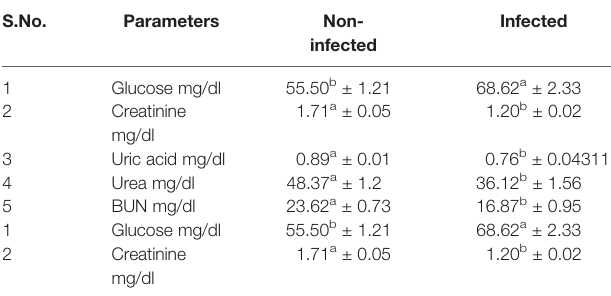
TABLE 6 | Biochemical parameters (kidney function test) in disease and non- infected sheep.